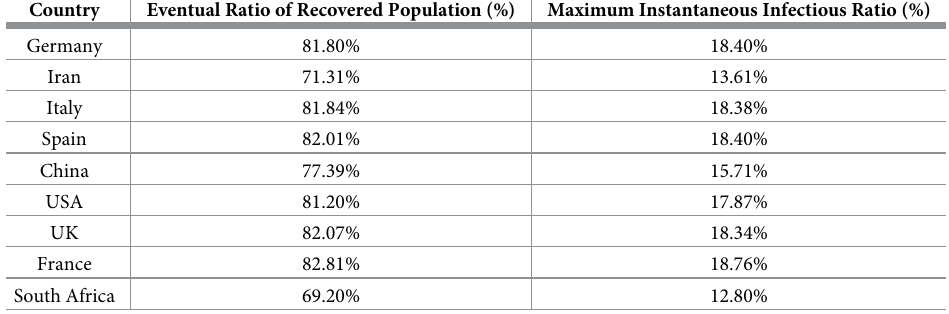
Table 6. Maximum instantaneous Infectious ratio and eventual Recovered ratio in different countries in the uncontained scenario for SIR model.